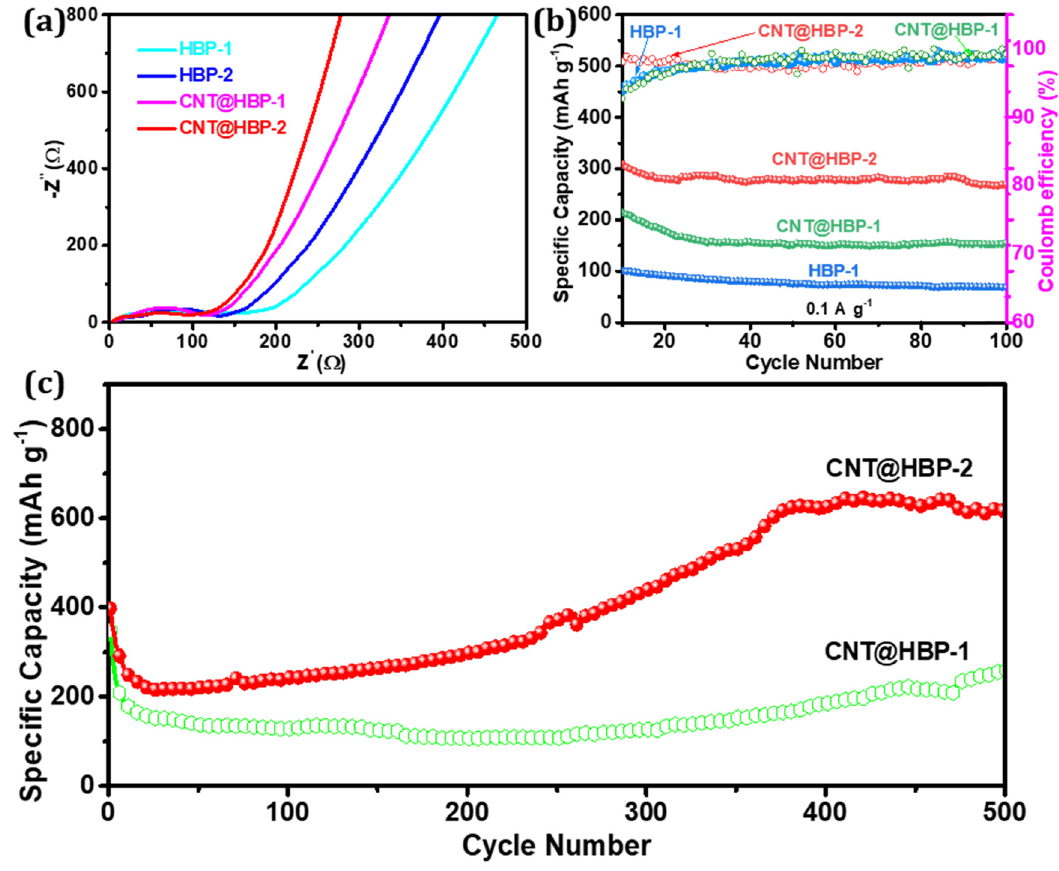
Figure 9: ( a ) Nyquist plots and ( b ) cycling stability of HBP - 1, HBP - 2, CNT@HBP - 1, and CNT@HBP - 2 at 0.1 A g − 1 for 100 cycles, and ( c ) long - term cycling stability of CNT@HBP - 1 and CNT@HBP - 2 at 0.5 A g − 1 for 500